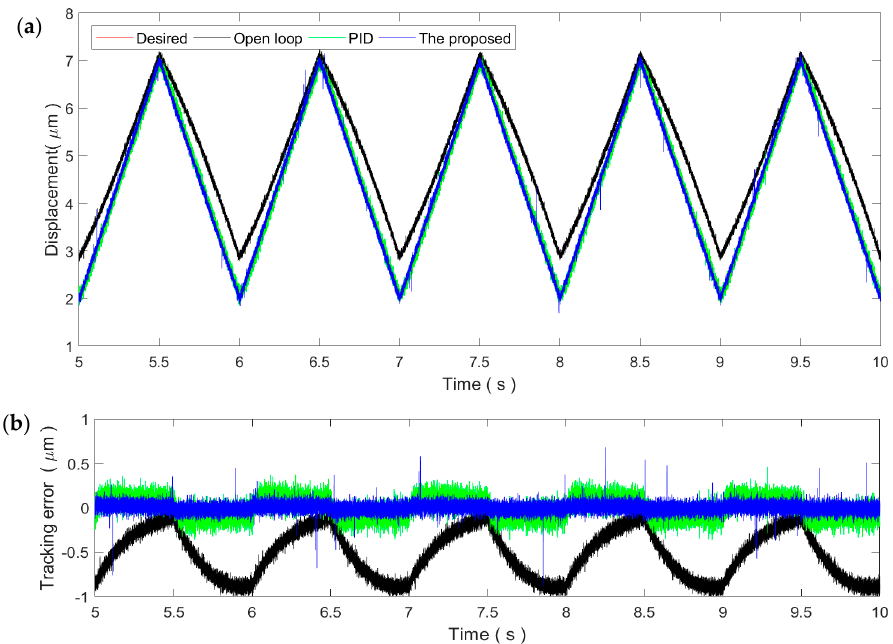
Figure 8. Tracking of the 1 Hz triangular trajectory: ( a ) Time plot and ( b ) tracking error.